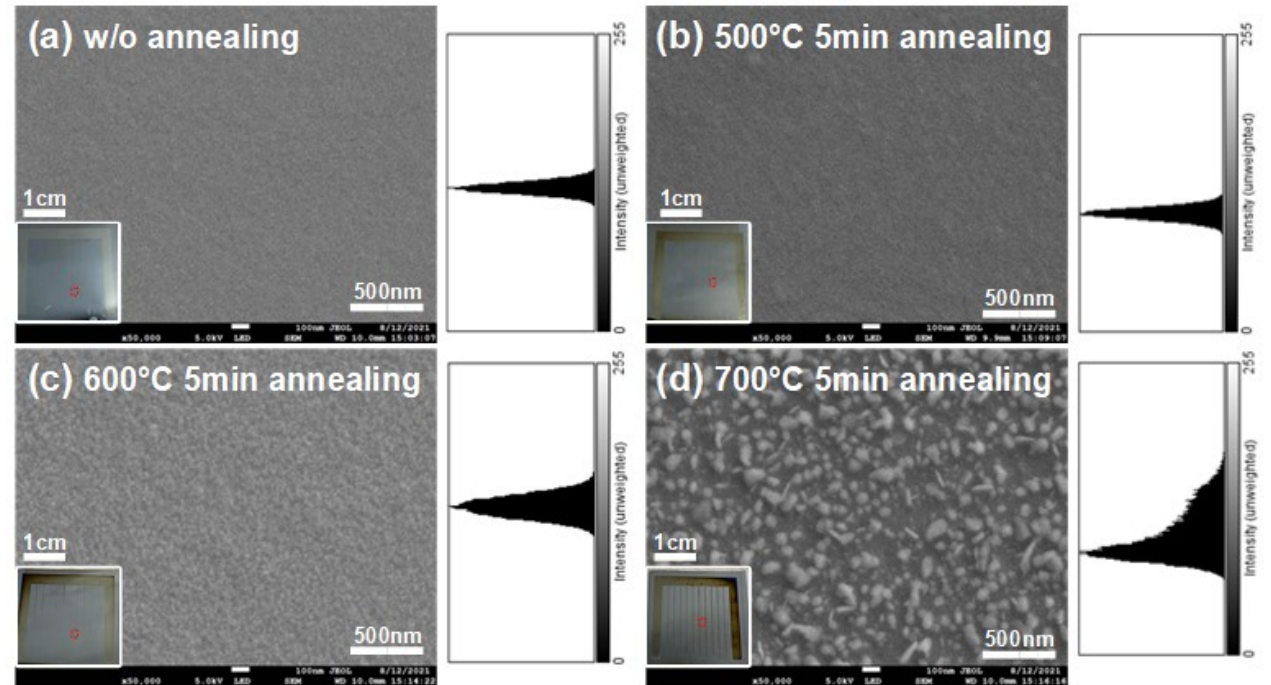
Figure 4. Scanning electron microscope images of the surfaces: ( a ) without annealing; ( b ) after annealing at 500 °C for 5 min; ( c ) after annealing at 600 °C for 5 min; ( d ) after annealing at 700 °C for 5 min.